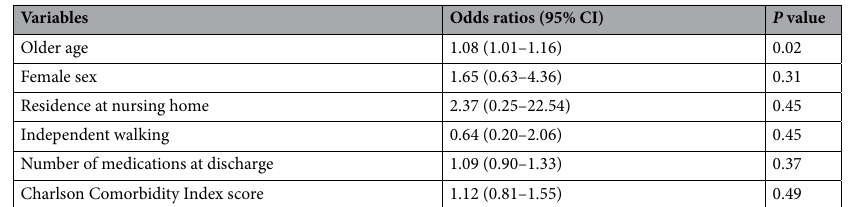
Table 3. Results of multivariable analysis for factors associated with the presence of PPOs at discharge. The following variables were used: age, sex, residence, Charlson Comorbidity Index score, ambulatory status, and number of medications at discharge. The level of statistical significance was set at 5%. CI confidence interval, PPO potential prescribing omission.